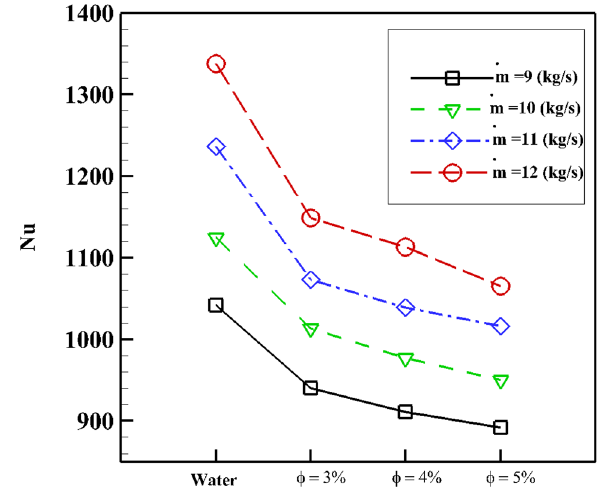
Fig. 19 Convective heat transfer at constant flow rate vs concentra- tion